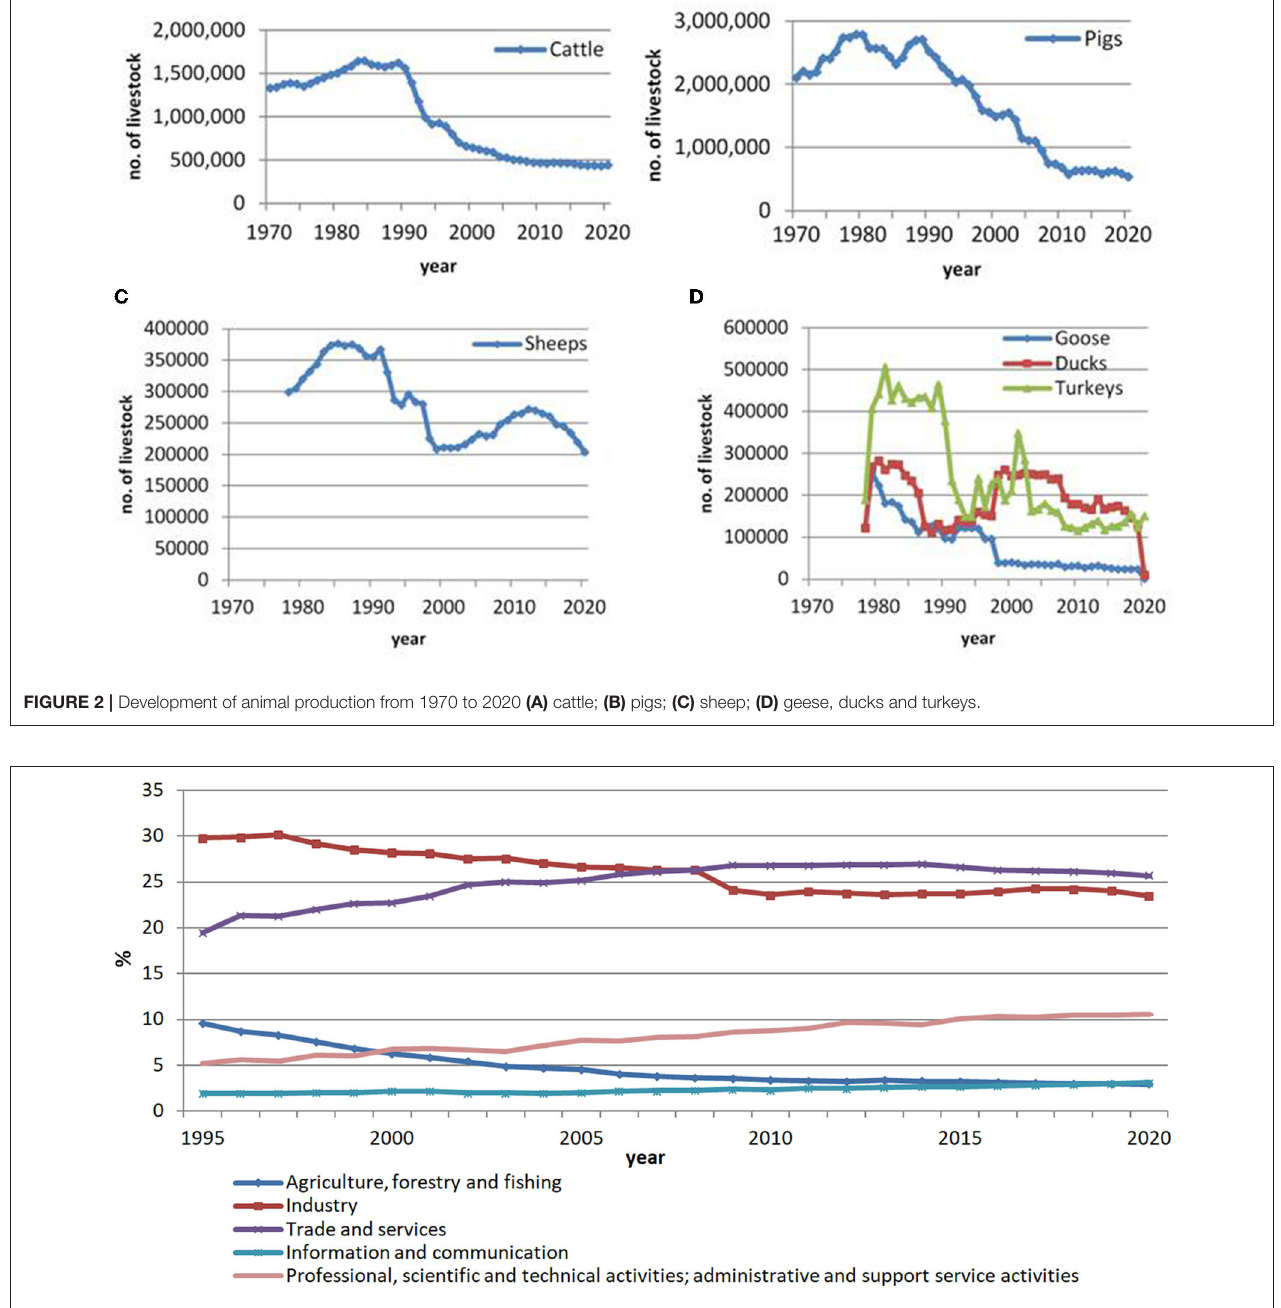
FIGURE 3 | Changes in the employment structure of selected sectors from 1995 to